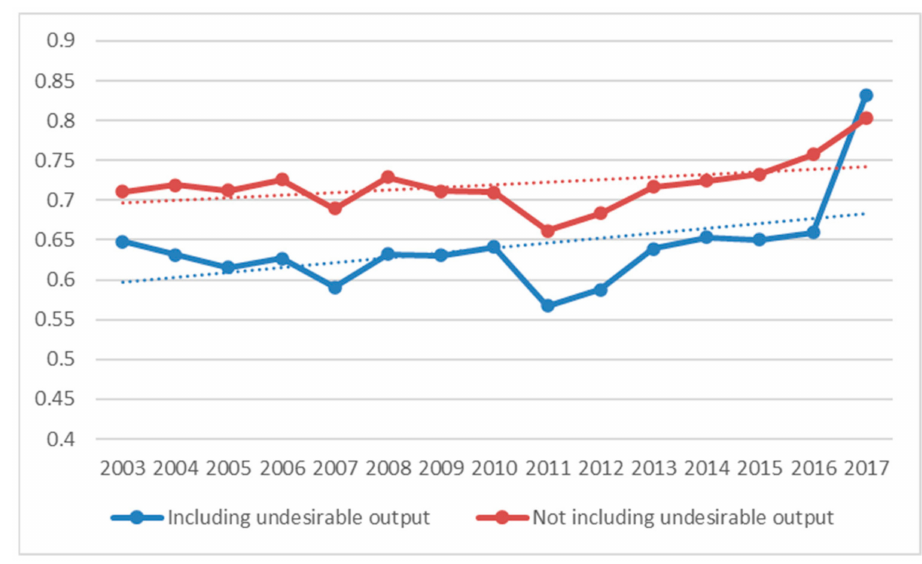
Figure 2. The Average Value of Urban Land Use Efficiency Over the